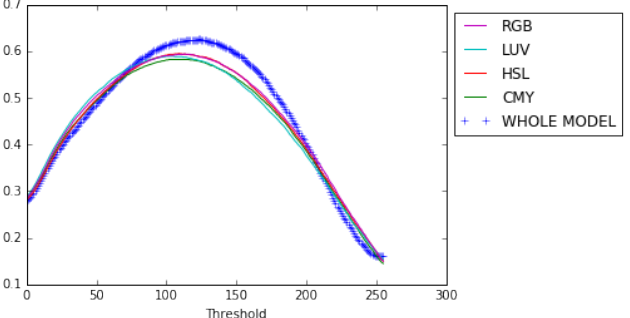
Figure 12. F β measure curves for color spaces RGB, HSL, LUV and CMY and the whole model on the ECSSD dataset.